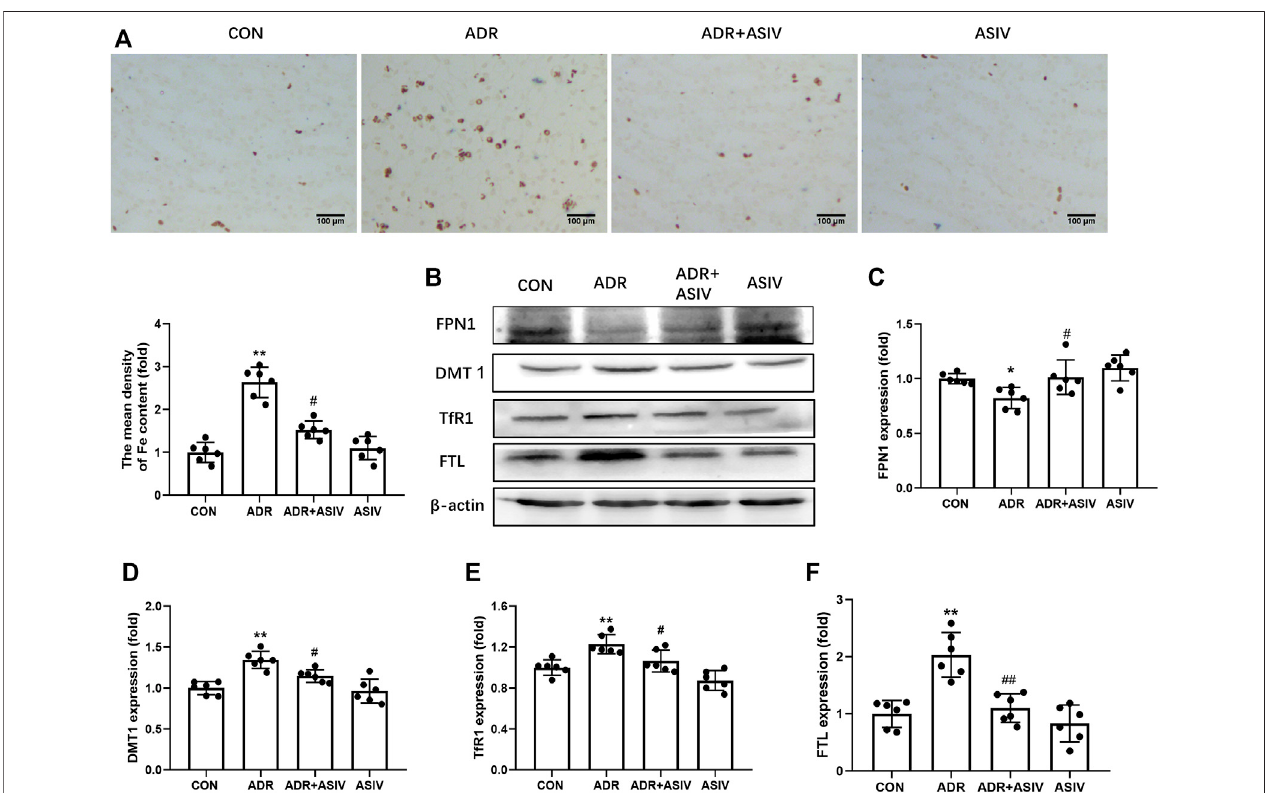
FIGURE3| ASIValleviatedironaccumulationinratswithADR-inducedrenaldamage(ADRdisruptsironmetabolism,whichleadstoirondepositioninrenaltissue). (A) Representative images of Perls ’ Prussian blue staining and quanti fi cation of iron accumulation. (B) Representative Western blotting photographs. (C) Renal FPN1 expression. (D) TheexpressionofDMT1. (E) TheexpressionofrenalTfR1. (F) RenalFTLexpression.Datawereexpressedasmean±SD, n =6.* p < 0.05,** p < 0.01vs. CON group. # p < 0.05, ## p < 0.01 vs. ADR